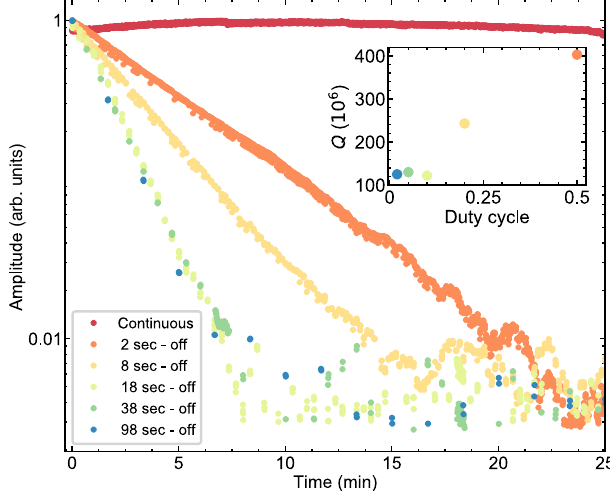
FIG. 15. Measurement of laser antidamping for different duty cycles. Ringdown measurement of a polygon resonator with varying duty cycles of the measurement strobes. The laser off time is swept while the on time is fixed to 1 s. Q ’ s are calculated from exponential fits to the data and are shown in the inset with marker color corresponding to the data traces.